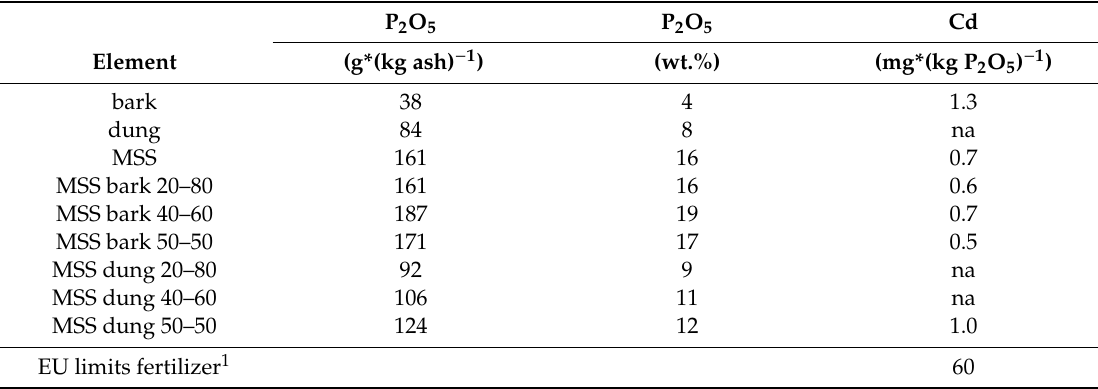
Table 5. Calculated concentrations from Table 3 where P 2 O 5 was calculated with the assumption that all P was in the form P 2 O 5